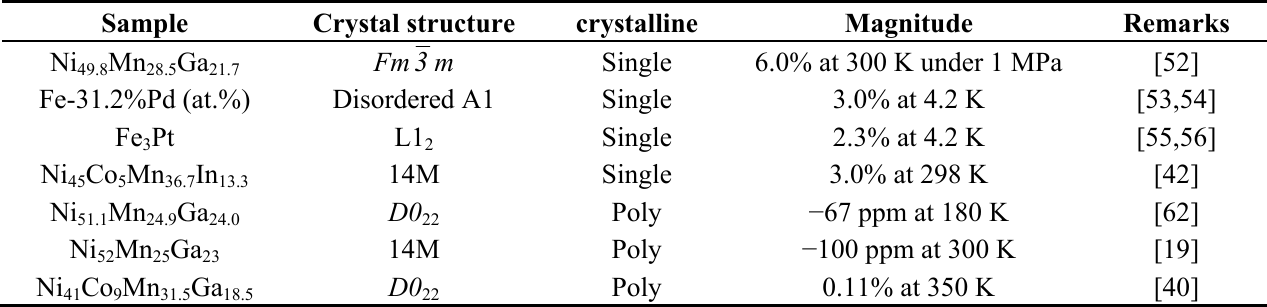
Table 3. The magnetic field induced strains and the magnetostrictions of shape memory